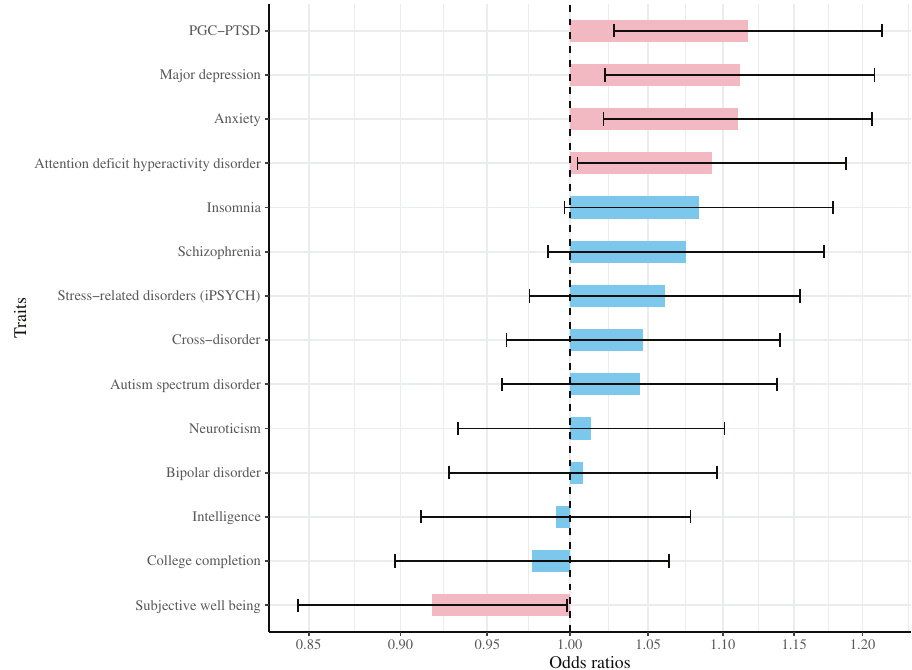
Fig. 2 Polygenic associations between common psychosocial traits and PTSD in childhood cancer survivors. iPSYCH The Lundbeck Foundation Initiative for Integrative Psychiatric Research, PGC Psychiatric Genomics Consortium, PTSD posttraumatic stress disorder. We performed polygenic risk score (PRS) analyses using genetic variants of P -value < 0.005 from corresponding GWASs of psychosocial traits. Odds ratios (per 1 standard deviation of standardized PRS) of PTSD in cancer survivors are shown as x -axis, while error bars indicate 95% con fi dence intervals. Pink bars denote signi fi cant associations ( P -value <